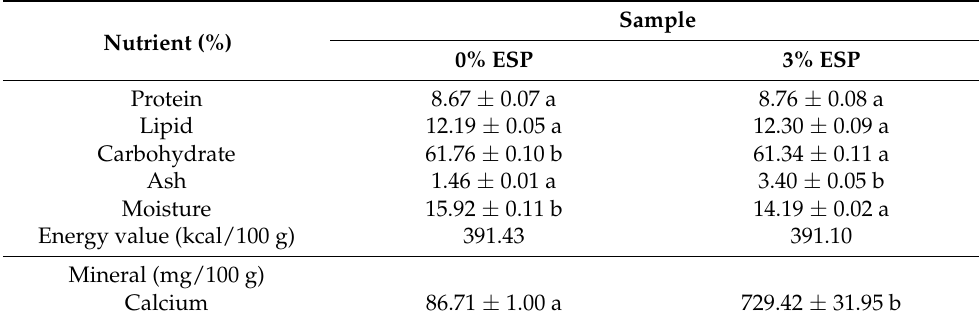
Table 2. Basic composition of gingerbread